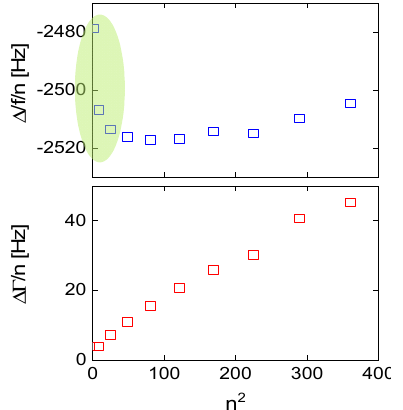
Figure A2. Overtone-normalized shifts of frequency and bandwidth obtained after depositing a polymer film with a thickness of about 500 nm onto the resonator plate. The area in green denotes values of Δ f / n , which are smaller than expected from the Sauerbrey relation. The difference goes back to flexural admixtures. Data from [47].